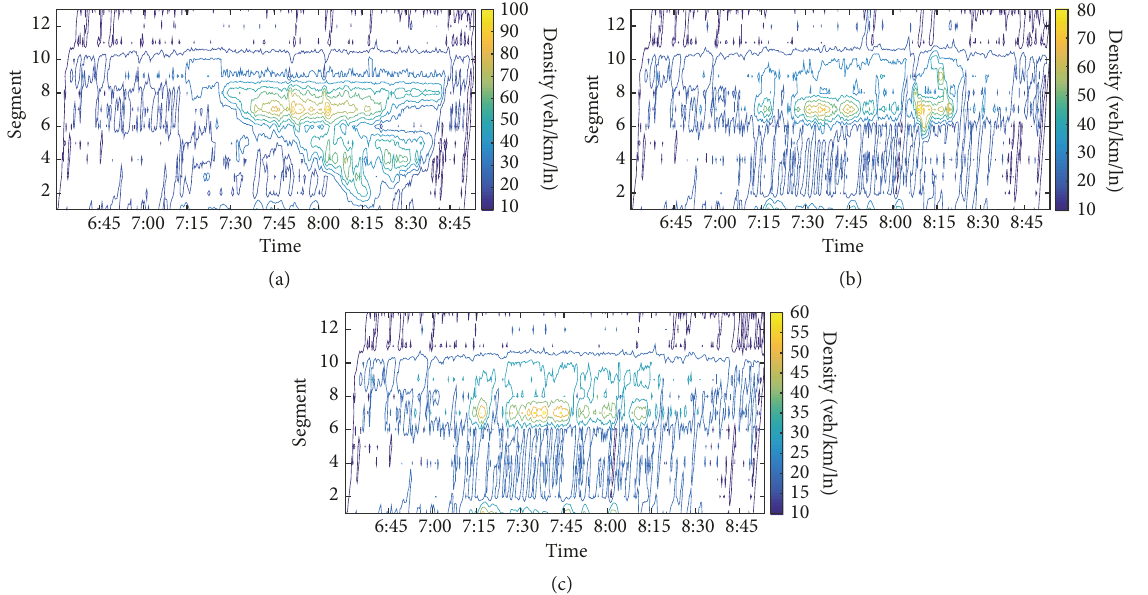
Figure 9: Comparison of segment densities of No-VSL, basic, and modified METANET-VSL controls: (a) no-VSL control; (b) basic METANET model; (c) modified METANET